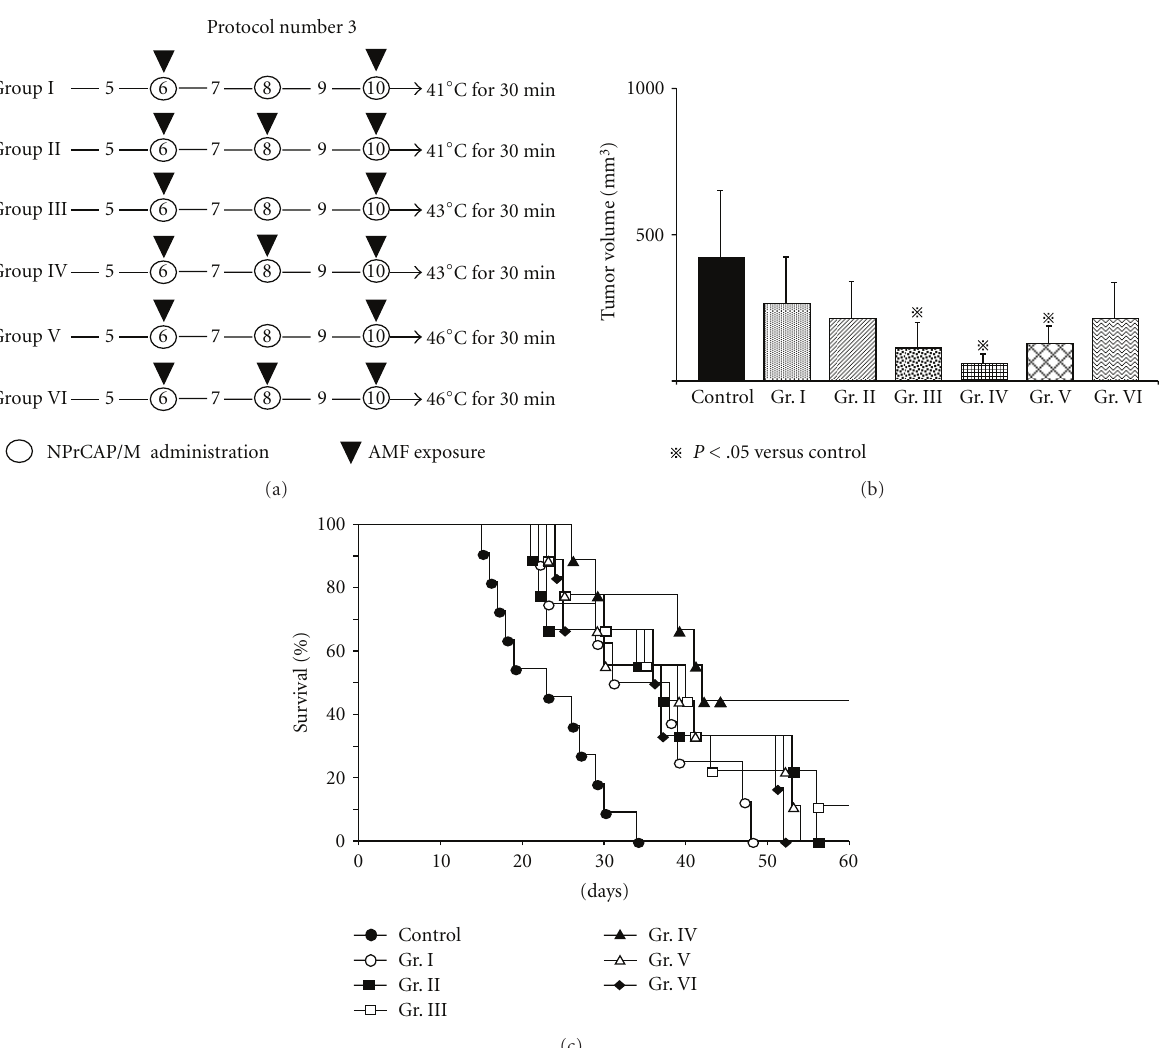
Figure 5: Time schedules and results for tumor volume, survival periods and rates of mice treated by Protocol number 3. (a) Protocols of Groups I, II, III, IV, V, and VI. (b) Tumor volumes on day 14 after re-challenge with B16F1 melanoma. All data are presented as mean ± standard deviation. Tumor volumes of Groups III, IV, and V were significantly reduced compared with the control group ( P = . 0045, . 0004, and . 0085 resp.) by the Sche ff ´e test. (c) Kaplan-Meier survival curve over a period of 60 days after tumor re-challenge. Survival rates of Groups III and IV were significantly prolonged compared with that of the control group ( P = . 0011 and . 0002, resp.). One of the nine mice in Group III and four of the nine mice in Group IV were protected against re-challenge with B16F1 melanoma